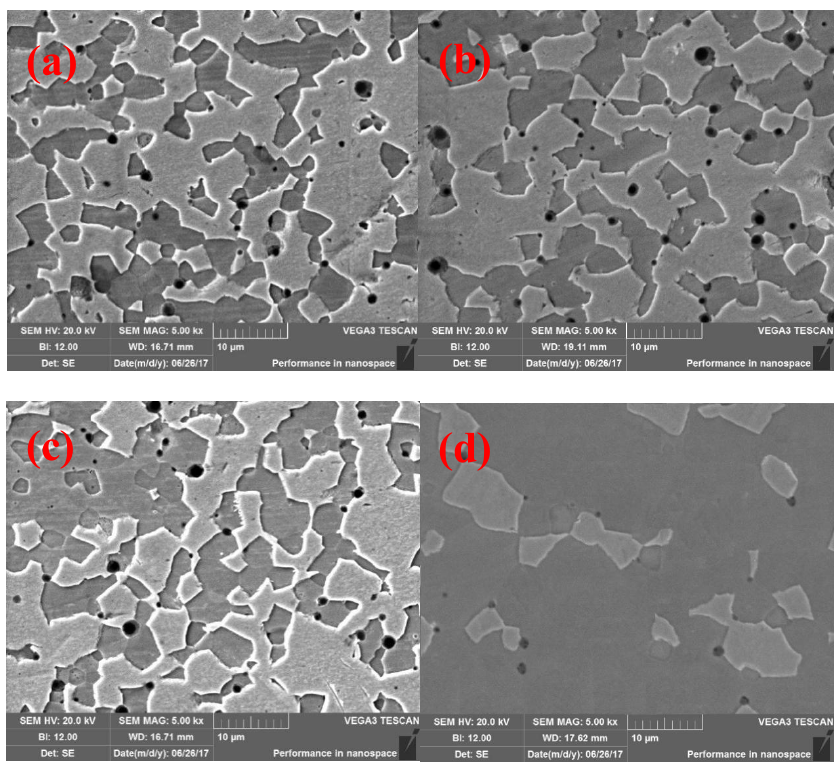
Figure 2. SEM images of the sintered alloys. ( a ) 10Si-7B alloy, ( b ) 12Si-8.5B alloy, ( c ) 14Si-9.8B alloy, and ( d ) 25Si-8.5B alloy.